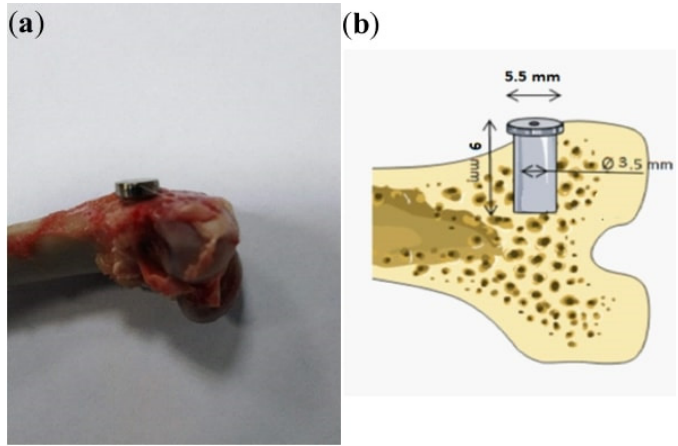
Figure 3. ( a ) Photograph of the extracted bone; ( b ) schematic representation of the implant